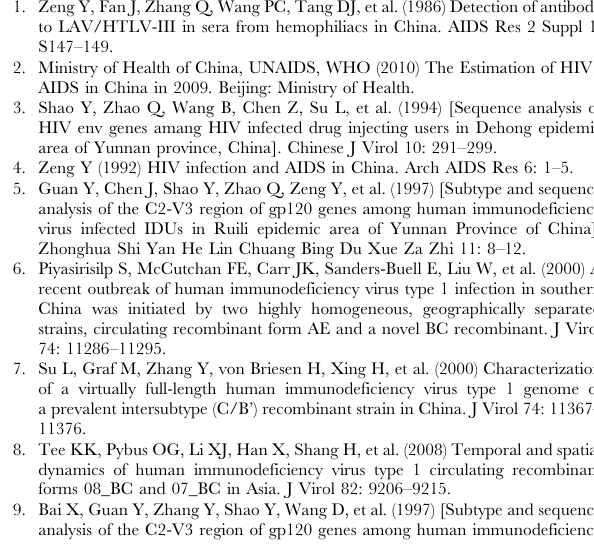
Table S2 Estimated distribution of HIV-1 genotypes in different regions/provinces in